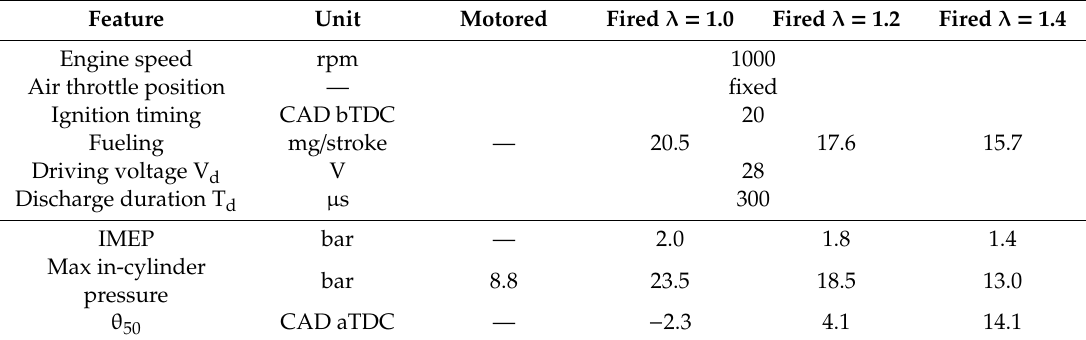
Table 4. Test points. Upper rows: settings; lower rows: main indicating results.